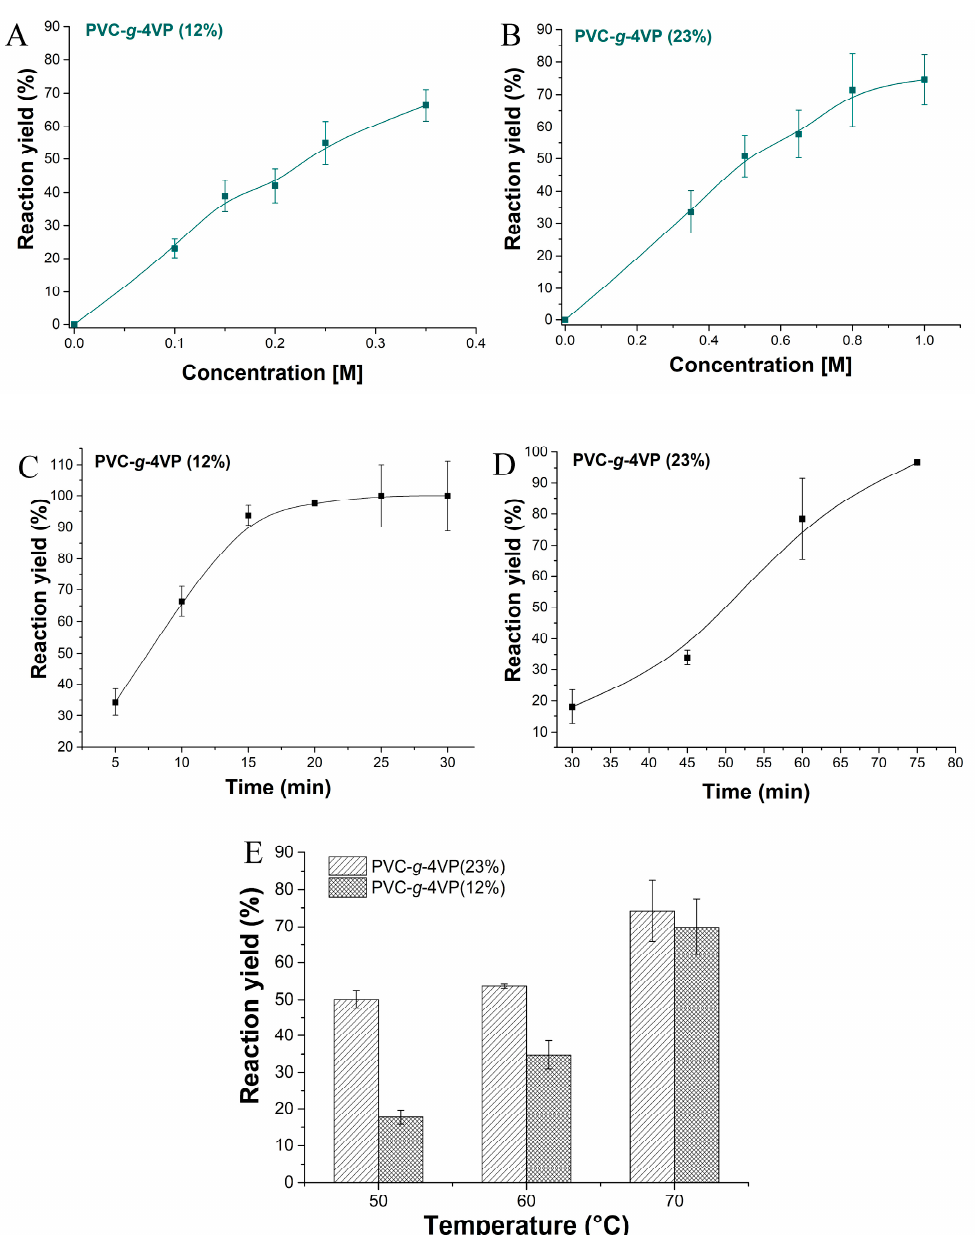
Figure 2. E ff ect of the reaction conditions in the yield percentage. ( A ) PS concentration e ff ect for PVC-g-4VP(12%), conditions: 70 °C and 10 min, ( B ) PS concentration e ff ect for PVC-g-4VP(23%), conditions: 70 °C and 75 min; ( C ) Time reaction e ff ect for PVC-g-4VP(12%), conditions: 70 °C and 0.35 M PS; ( D ) Time reaction e ff ect for PVC-g-4VP(23%), conditions: 70 °C and 0.8 M PS; and ( E ) Temperature e ff ect, conditions for PVC-g-4VP(12%): 0.35 M PS and 10 min, and conditions for PVC-g-4VP(23%): 0.8 M PS and 75 min. Reported: mean ± standard error of the mean, n = 3.